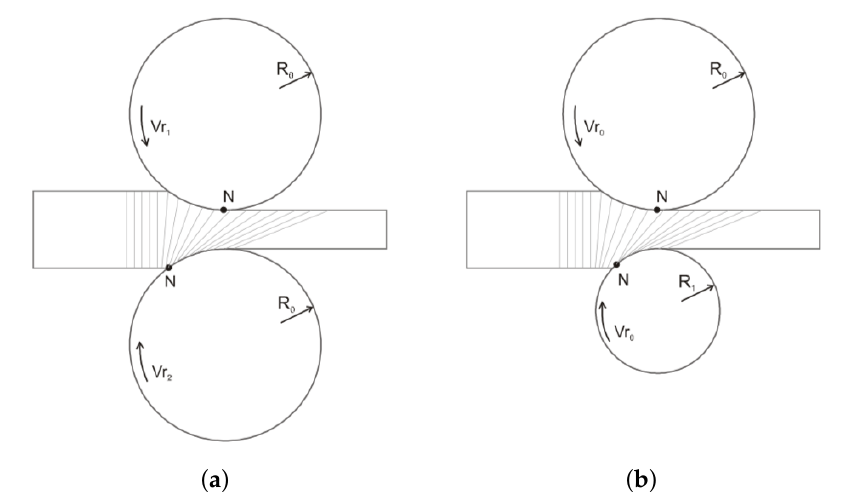
Figure 2. Representation of the new positions of the neutral points (N) for the two surfaces of the sheet during asymmetric rolling: ( a ) for the case of identical roll diameters and ( b ) for the case of different roll diameters (adapted from [25], with permissions from authors,